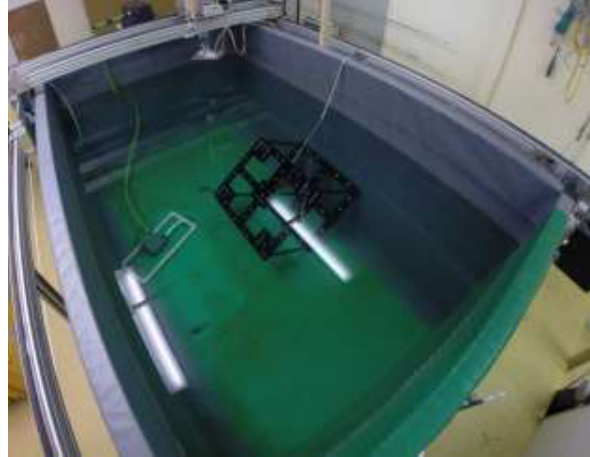
Figure 2: Controlled test field environment - calibration frame in water